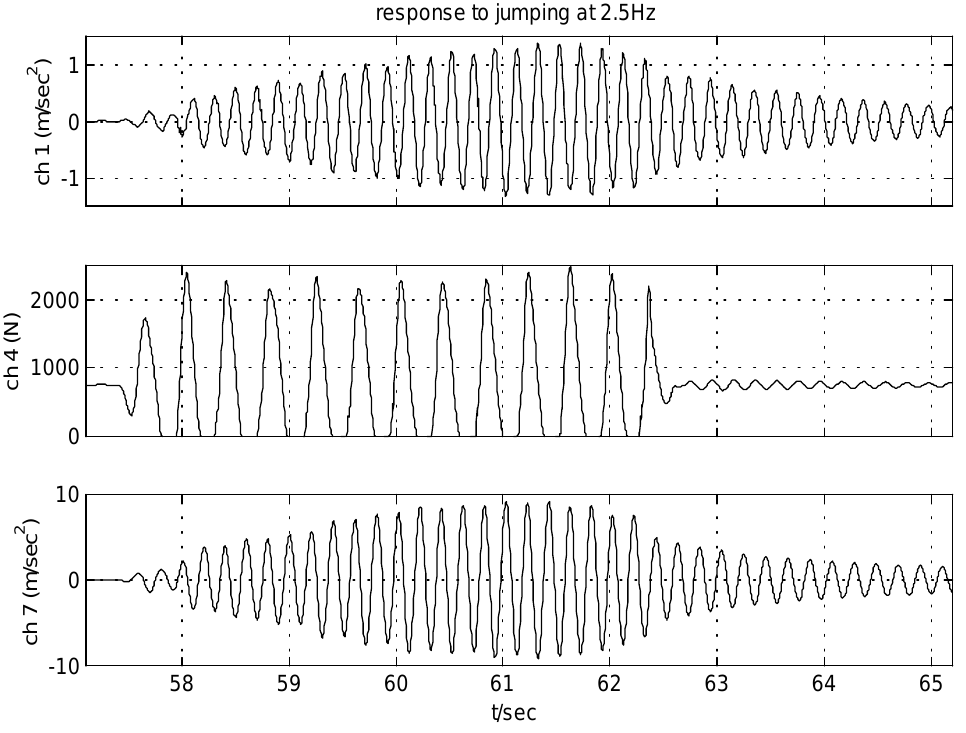
Fig. 7. 80 kg test subject jumping at 2.5 Hz. top: measured acceleration response middle: measured contact force Bottom: simulated acceleration response for 1000 kg mass. measurement of contact force isolates any influence of jumper dynamics, hence the modal mass estimate should be reliable. In the decay phase, since the contact force has been recorded, the mechanism of the enhanced damping could be studied. In fact it should be possible to estimate energy input (before 62 seconds) and energy extraction (after 62